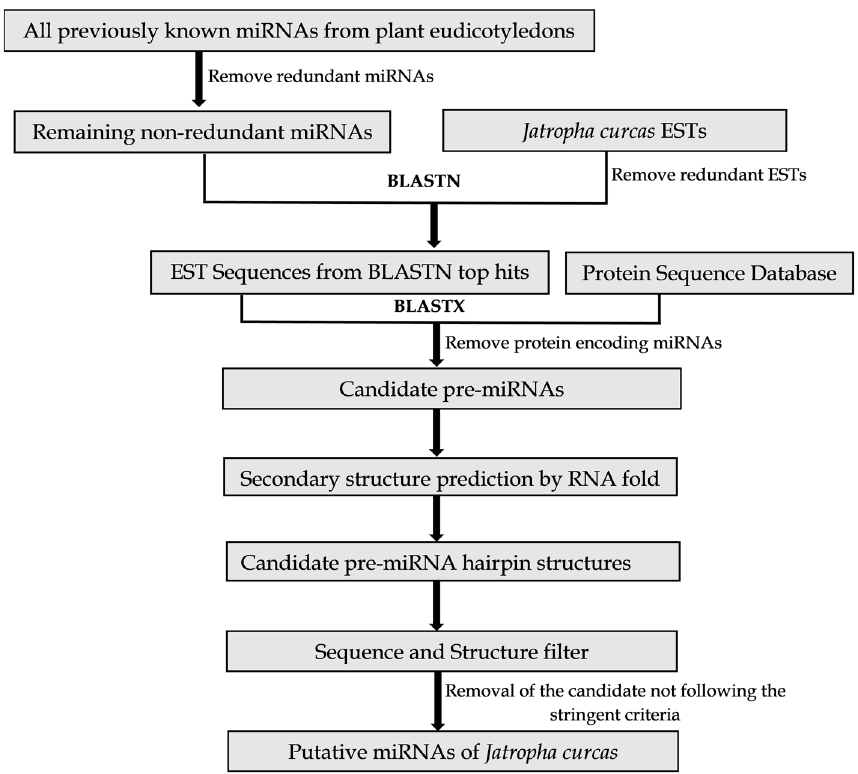
Fig. 1 Schematic workflow for the identification of novel miRNAs in J.